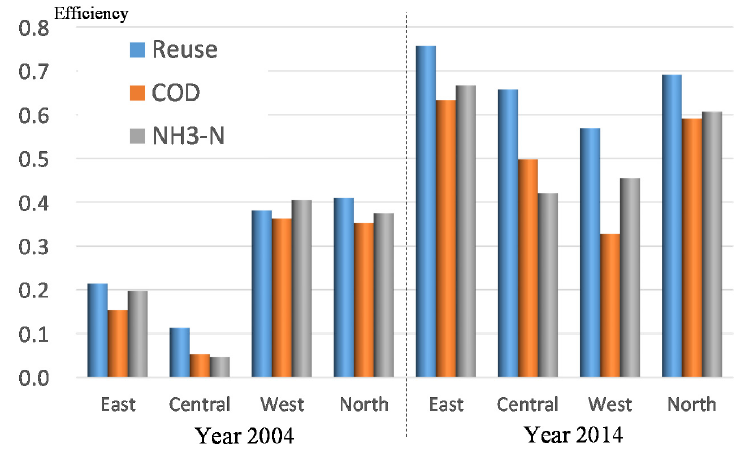
Figure 4. Regional average wastewater management efficiency from 2004 to 2014.